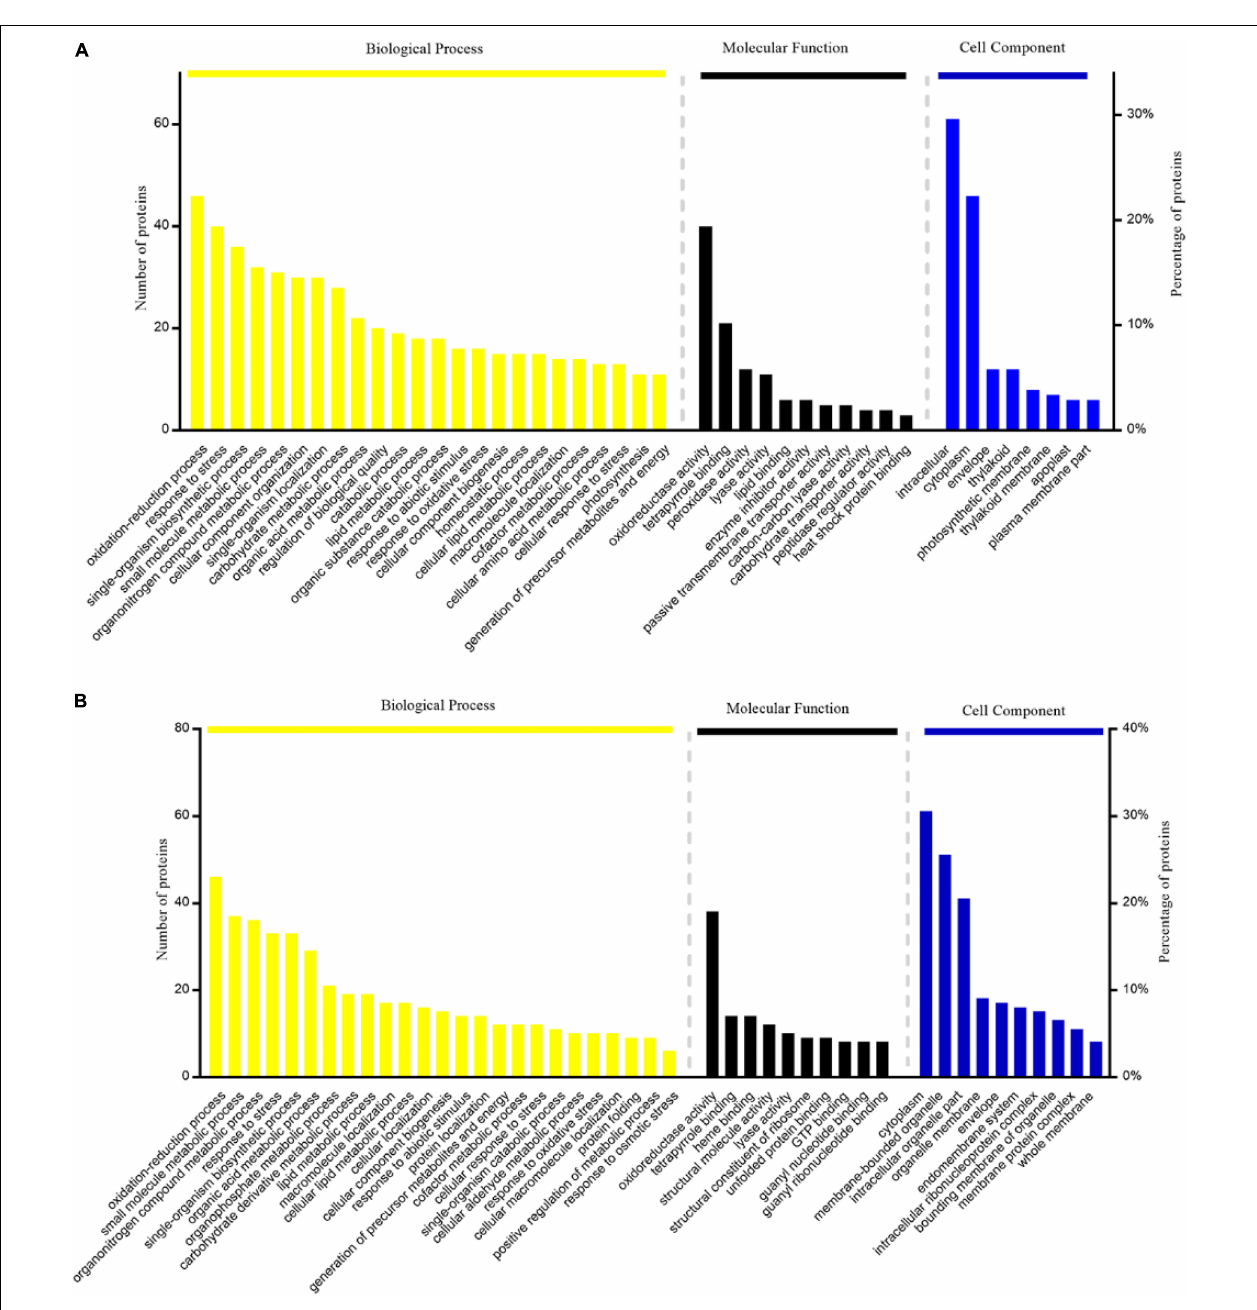
FIGURE 4 | GO enrichment analysis of proteins with differential abundance: (A) three-leaf stage SP2 vs CK; (B) tillering stage SP2vs CK.